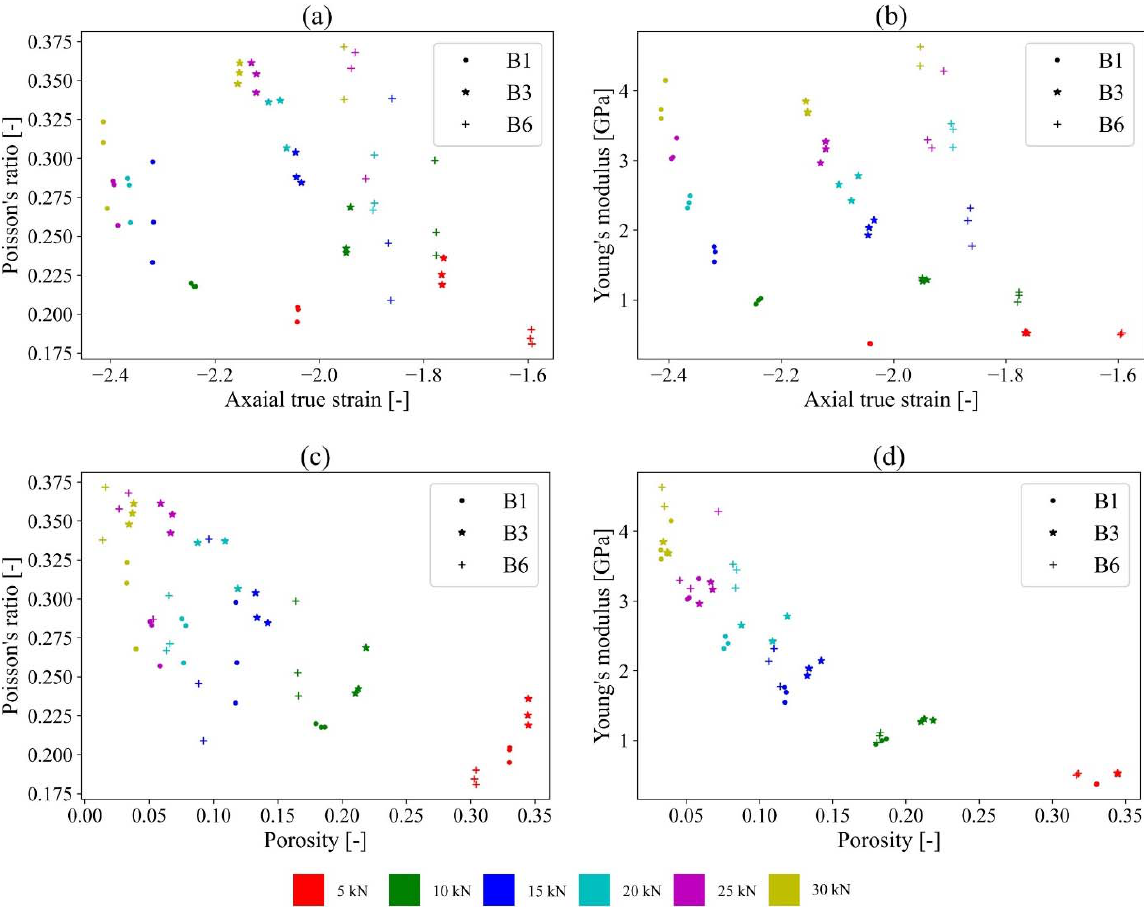
Figure 4. Poisson’s ratio and Young’s modulus of granule batches B1, B3, B6 at different compaction force levels. Poisson’s ratio—axial true strain ( a ); Young’s modulus—axial true strain ( b ); Poisson’s ratio—porosity ( c ); Young’s modulus—porosity ( d ).